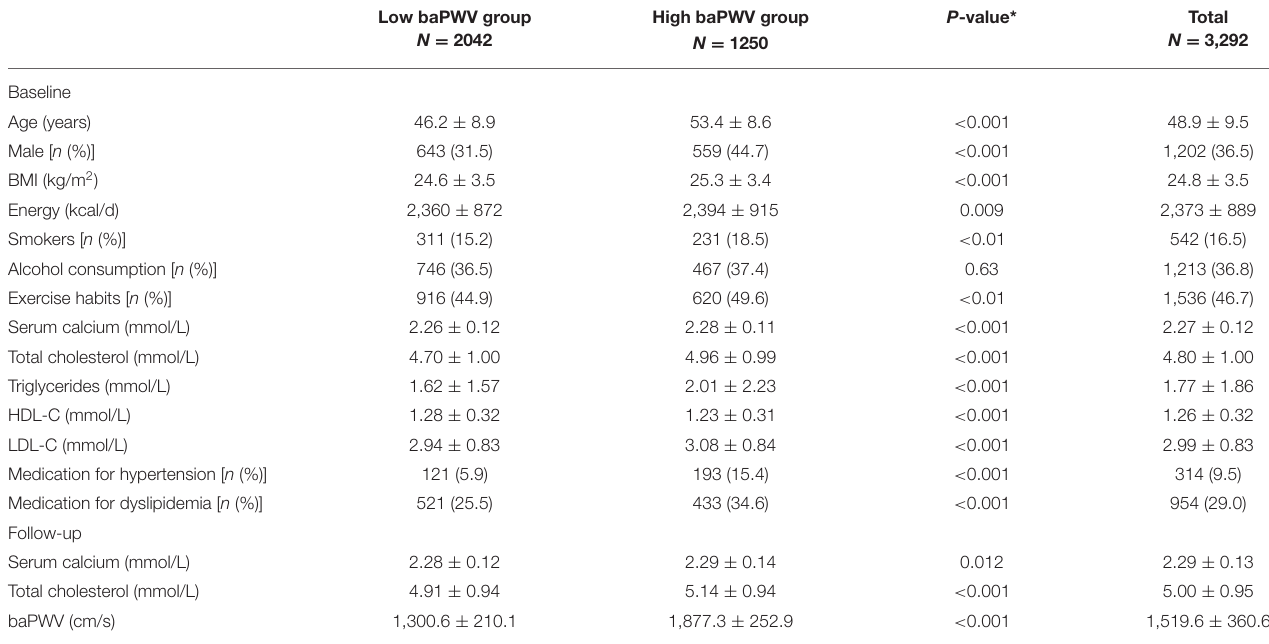
TABLE 1 | The characteristics regarding the study variables at the baseline and follow-up by baPWV in the Harbin Cohort Study on Diet, Nutrition, and Chronic Non-communicable Disease Study